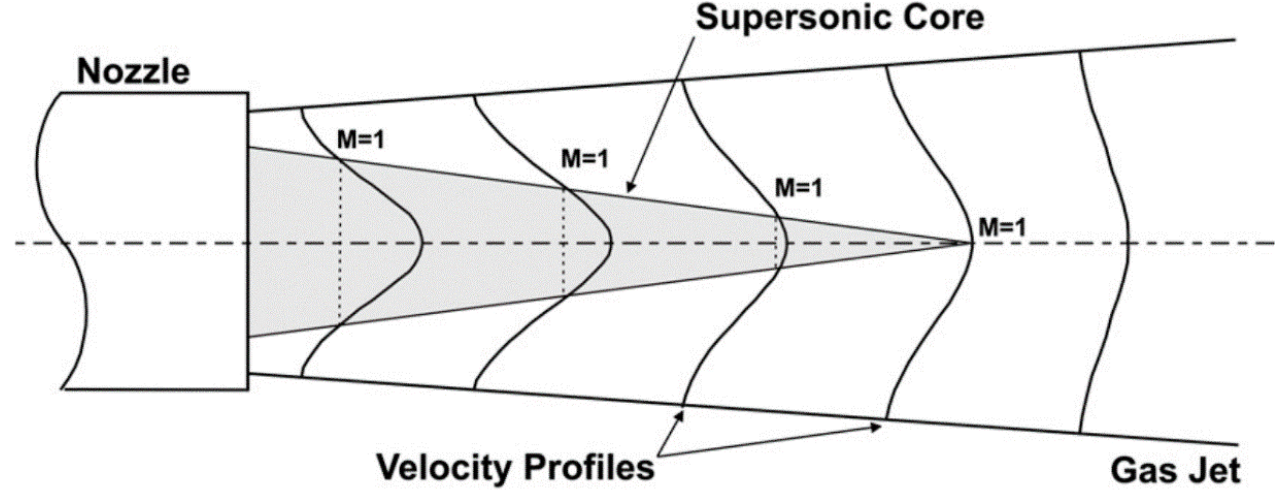
Figure 3. Schematic representation of a nozzle’s supersonic core. Reprinted with permission from [70]. Copyright 2008 Elsevier.